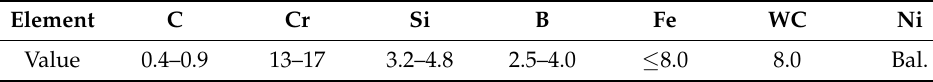
Table 1. Main components of powder (%).